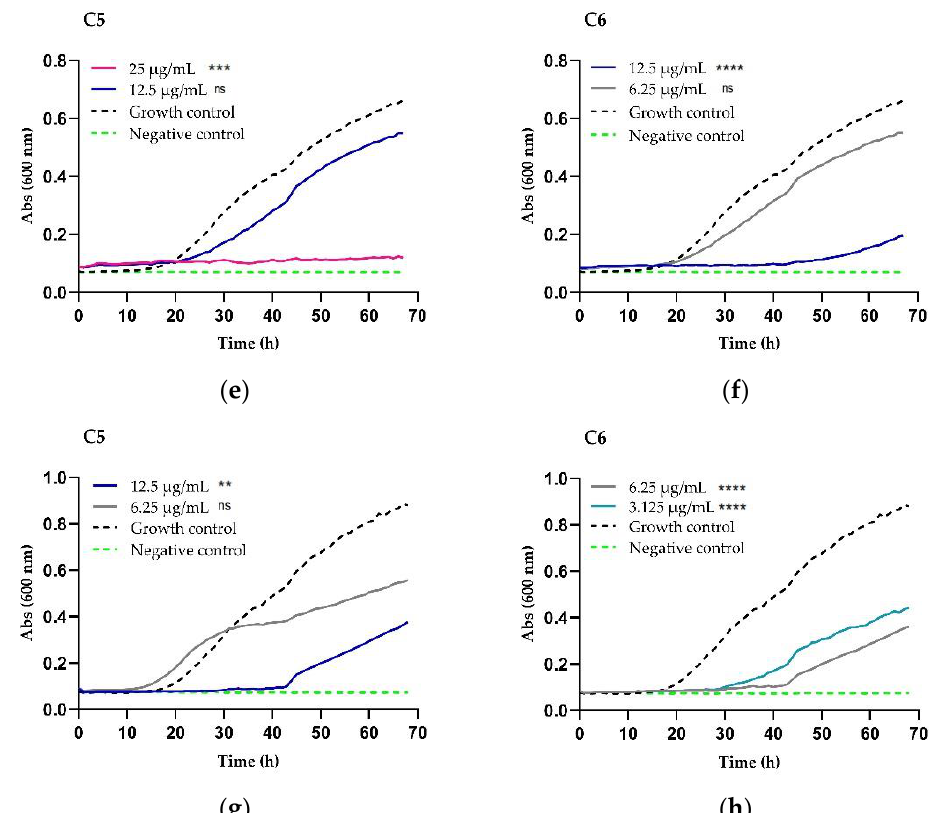
Figure 1. Chimeric peptides time – kill curve against C. neoformans var. grubii . ( a , b ) H99 strain; ( c , d ) clinical isolate 2807; ( e , f ) clinical isolate 3279; and ( g , h ) clinical isolate 2643. The asterisks represent the significance (* p < 0.05, ** p < 0.01, *** p < 0.001, **** p <0.0001) among the strains exposed to the different concentrations and the strains without treatment (growth control or positive control); not significant (ns). RPMI medium without yeast and peptide (sterility control or negative). Table 3. Growth inhibition test . Antifungal activity of chimeras against C. neoformans var. grubii.